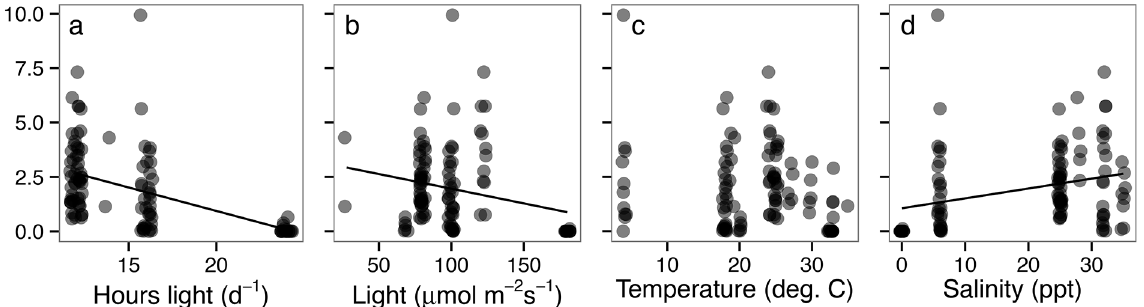
Fig 2. Post-hoc correlations between continuous culture conditions and the Σ LCEFA in the % DW dataset. Panels: (a) hours light, (b) light intensity, (c) temperature, and (d) salinity for all phytoplankton groups pooled together. Each point is from a different % DW fatty acid profile (i.e., not species means), and all points are the same tone of grey, but are plotted with semi-transparency and jittering to accommodate for overplotting of points with similar values. Best-fit lines are significant (Kendall ’ s Tau, p < 0.05).